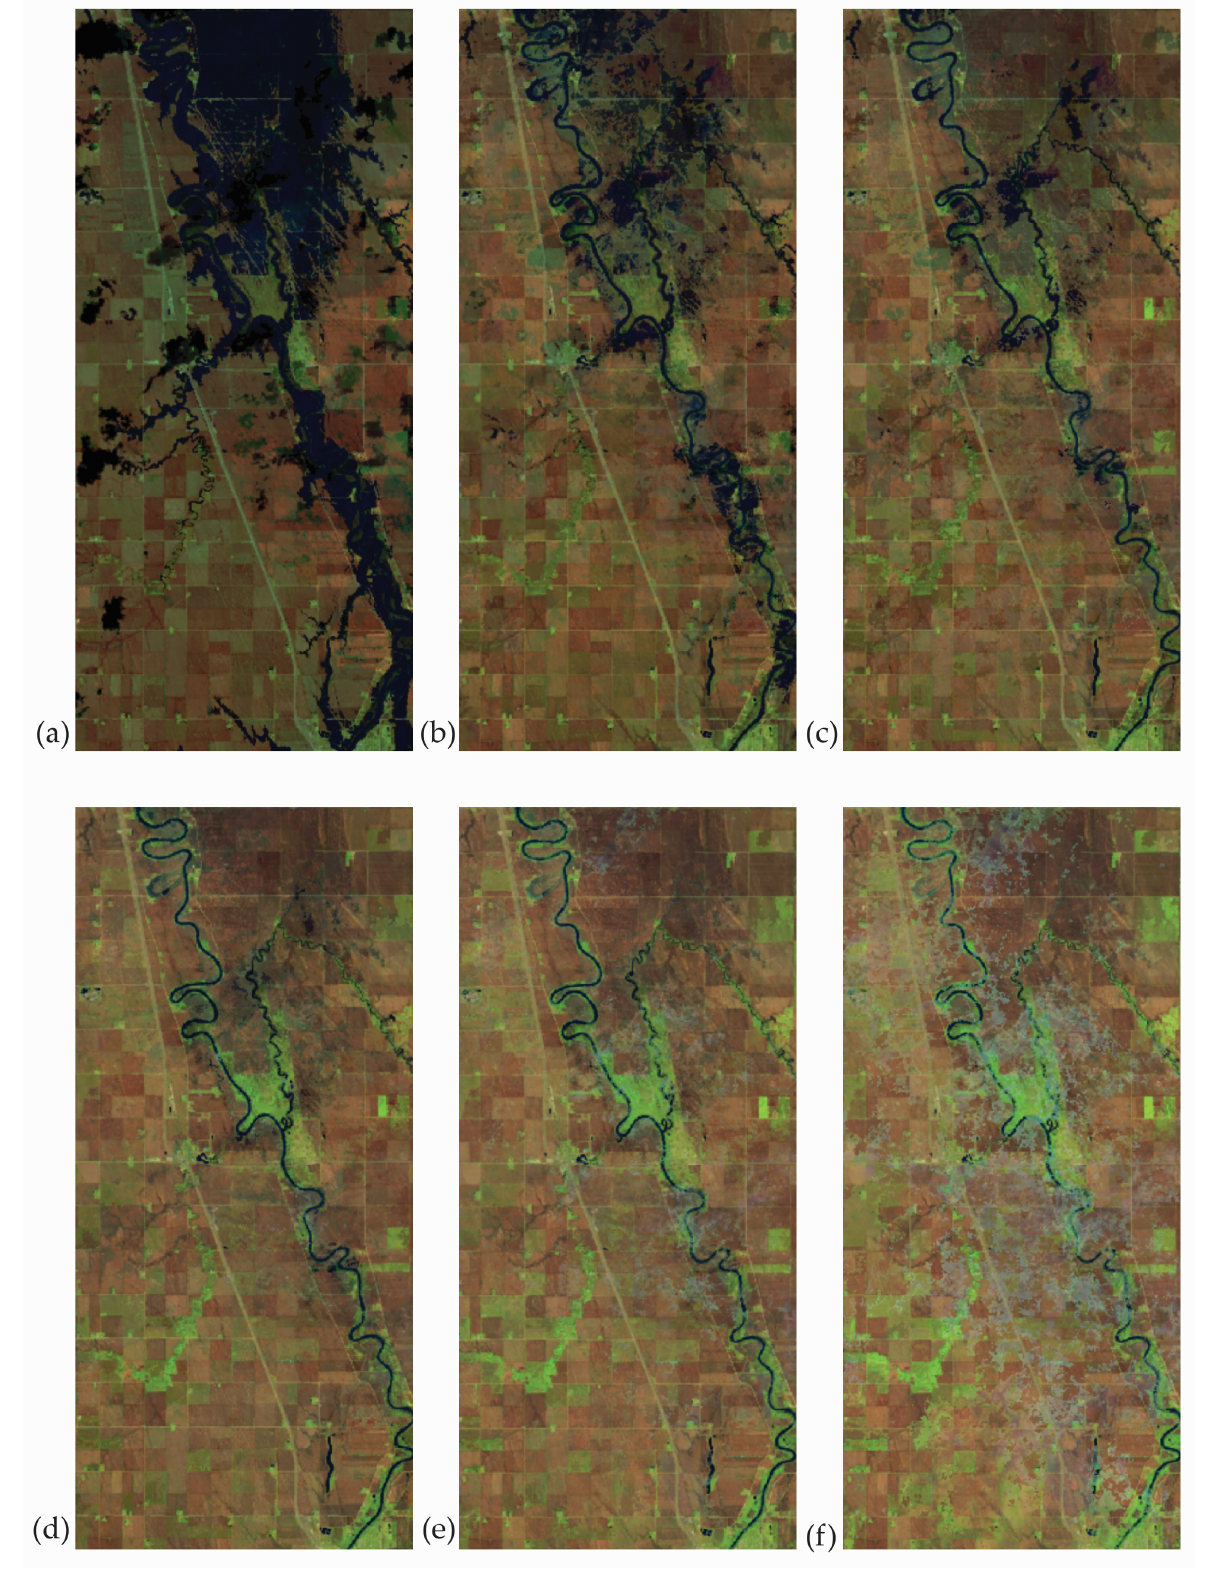
Figure 3. Intensity percentile false-color images for 2019 Red River flood ( a ) 10 percentile; ( b ) 20 percentile; ( c ) 30 percentile; ( d ) 40 percentile; ( e ) 50 percentile; ( f ) 60